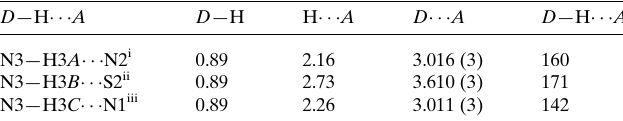
Table 1 Hydrogen-bond geometry (A˚ , (cid:5) ).